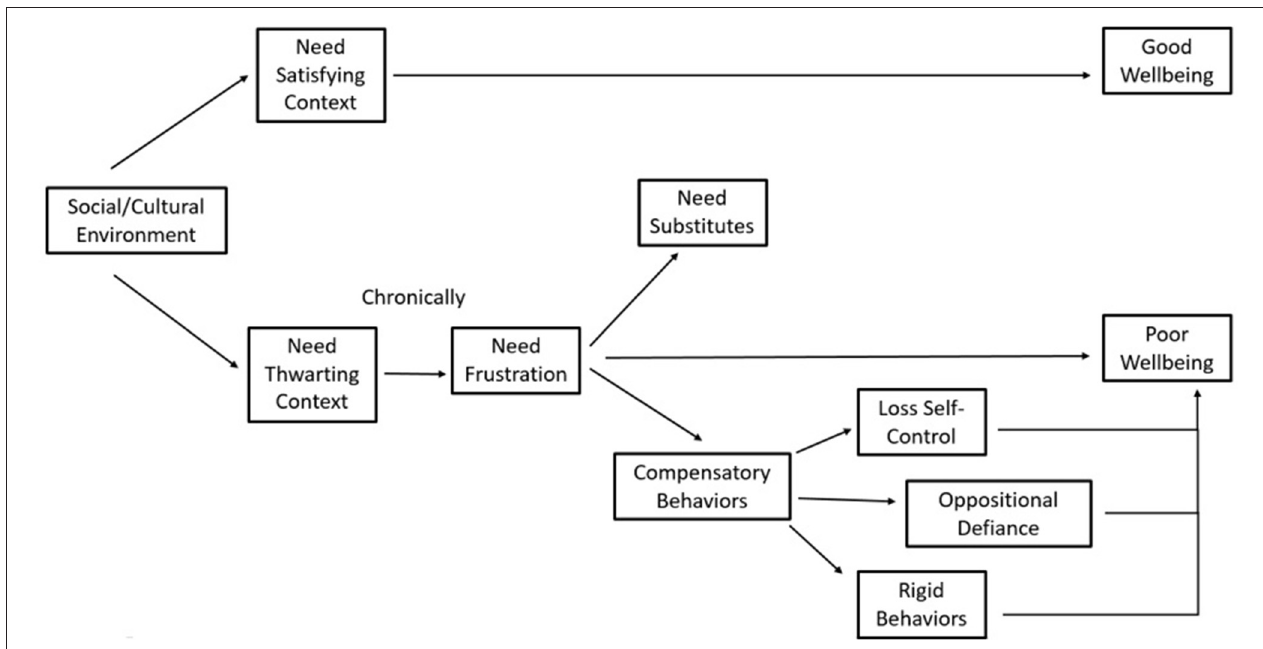
FIGURE 1 | Framework of basic psychological needs theory (BPNT).